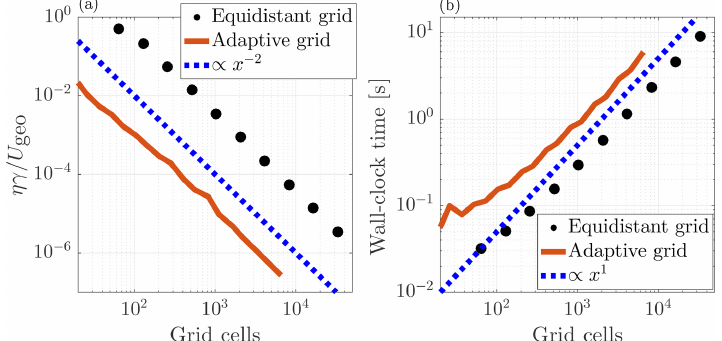
Figure 3. The scaling characteristics for the laminar Ekman-spiral case. Panel (a) presents the error convergence for the equidistant-grid and adaptive-grid approach. The errors ( η ) follow the slope of the blue dashed line that indicates the second-order accuracy of the methods. The wall-clock time for the different runs is presented in (b) , showing that for both of the aforementioned approaches, the required effort scales linearly with the number of grid